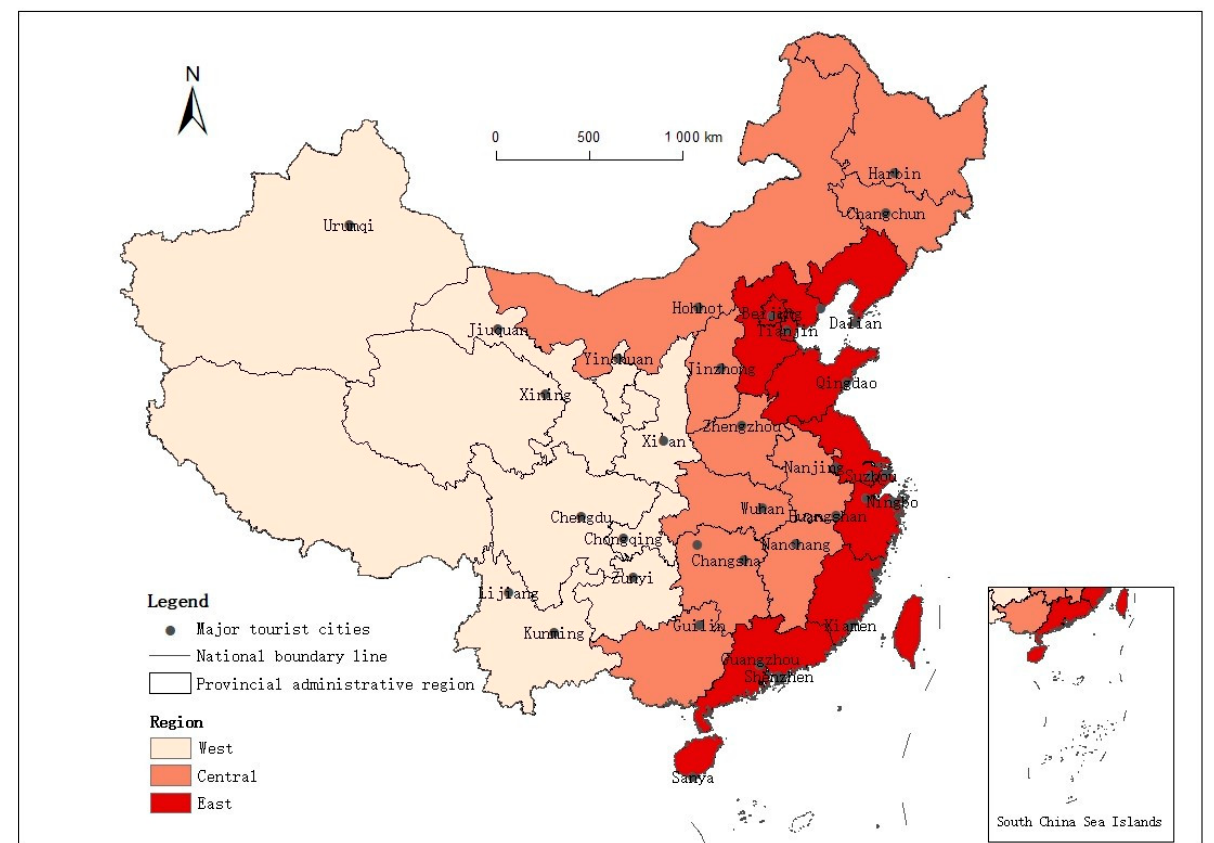
Figure 1. Major tourist cities in